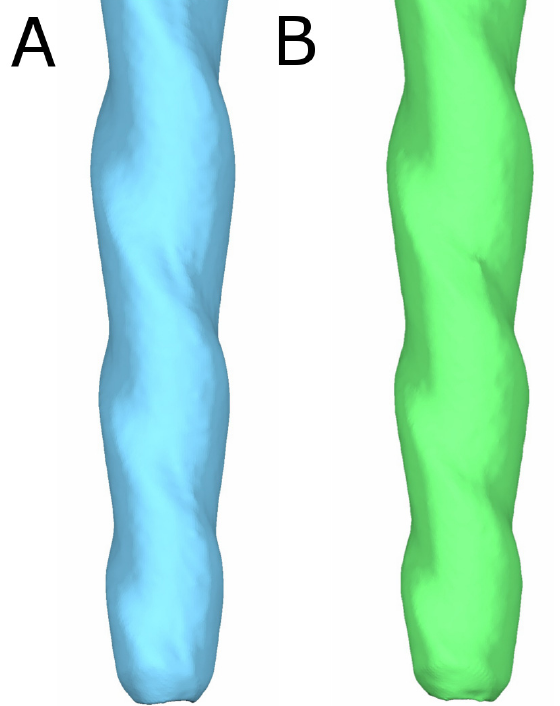
Figure 1. Three-dimensional reconstruction of the ( A ) preoperative and ( B ) postoperative micro-CT scans of a CM-wire NiTi alloy endodontic reciprocating file.